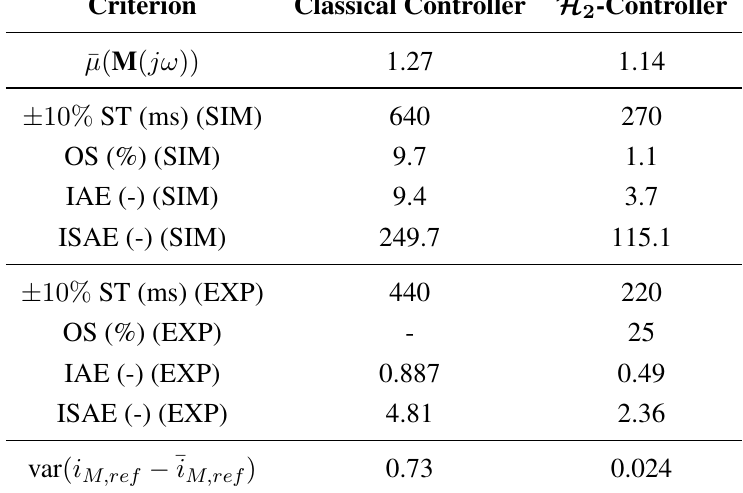
Table 1. Controller comparison (settling time (ST), overshoot (OS), integral of absolute errors (IAE), integral of square errors